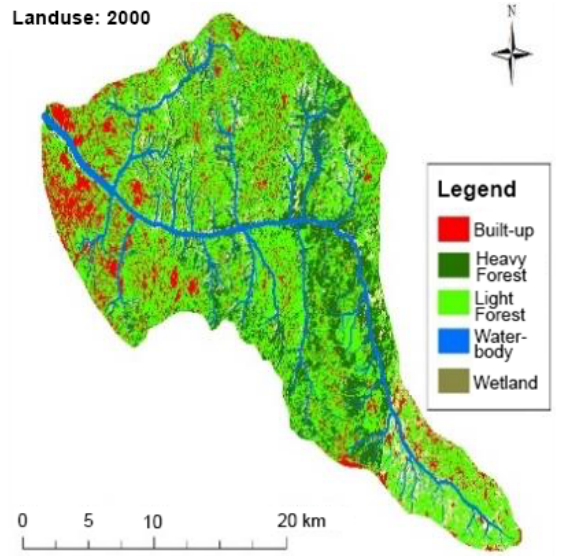
Figure 3. Landuse/landcover pattern in 2000.